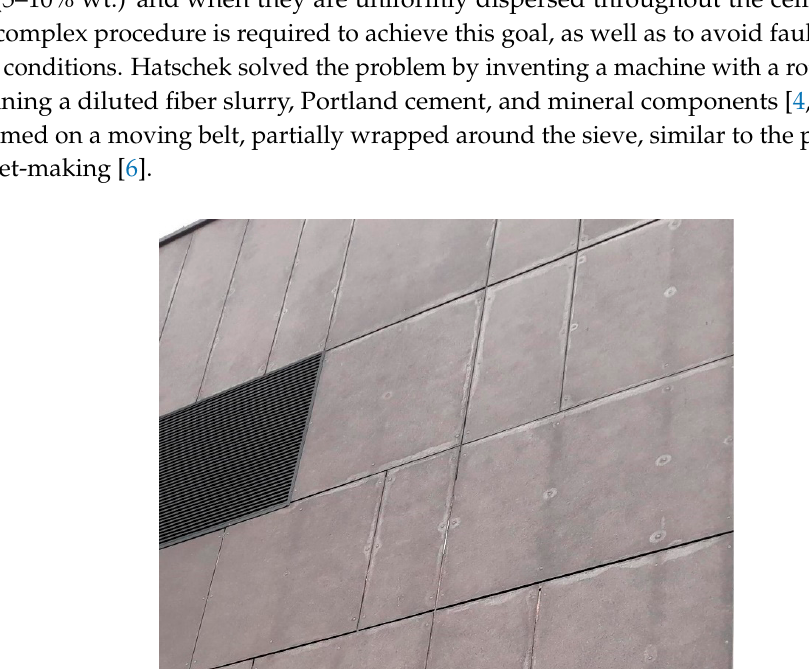
Figure 1. An example of a FCB façade showing considerable damage after ten years of exposure to climate hazards. climate